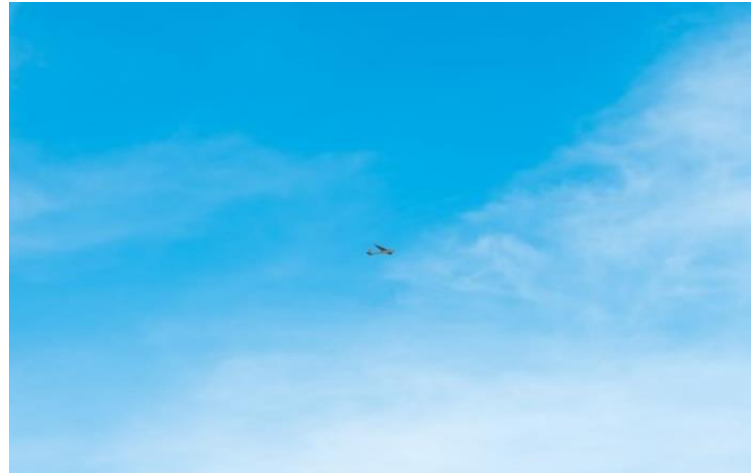
Figure 11. Synthetic image rendered by Blender.